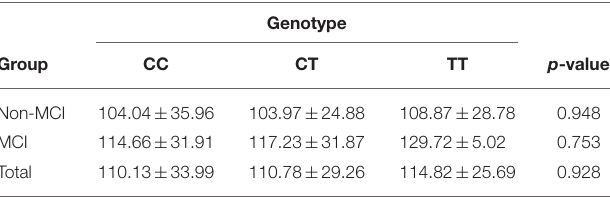
TABLE 4 | The plasma levels of clusterin (ug/ml) in T2DM patients with MCI or normal